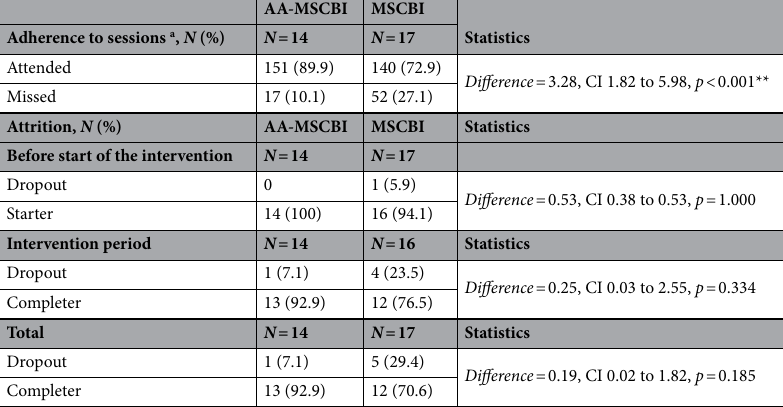
Table 4. Adherence to treatment and attrition for the animal-assisted psychotherapeutic mindfulness- and self-compassion-based group intervention (AA-MSCBI) and the standard psychotherapeutic mindfulness- and self-compassion-based group intervention (MSCBI). a All patients allocated to treatment, N number of patients, % percentage of patients, Difference : coefficient estimating the mean difference as effect size, CI 95% confidence interval, ** p <